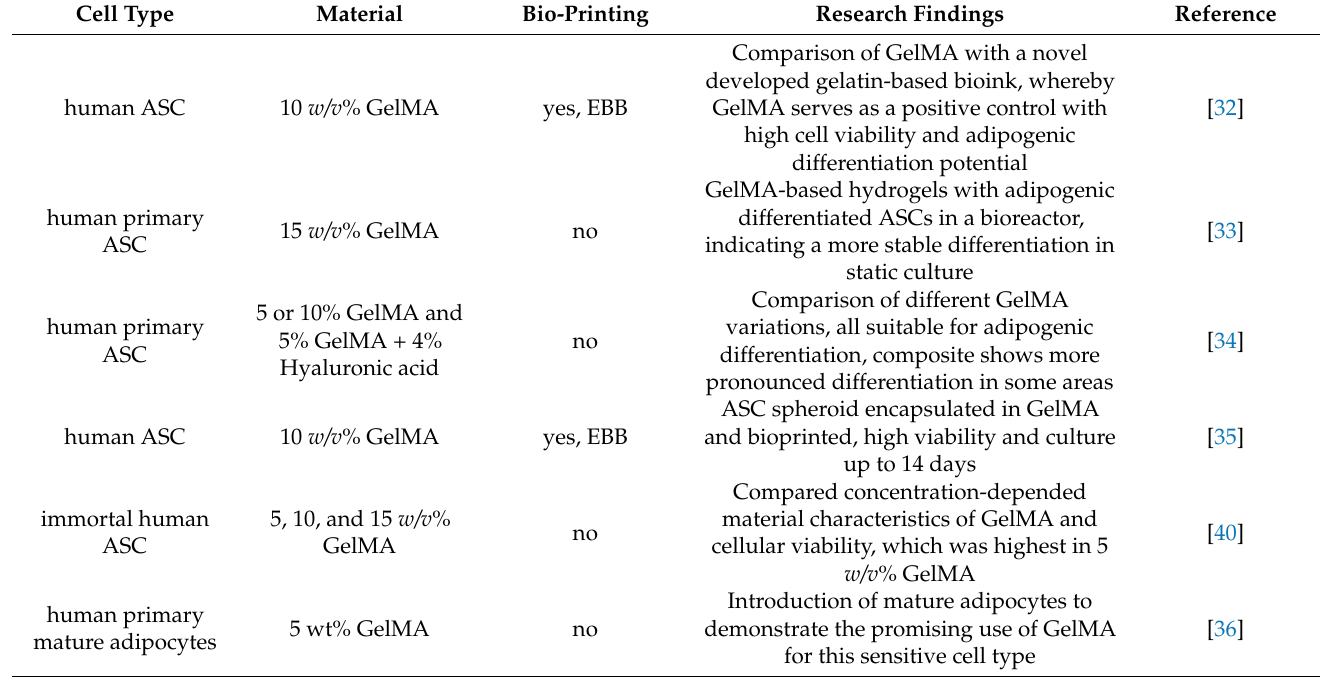
Table 1. Literature using GelMA for the construction of adipose tissue